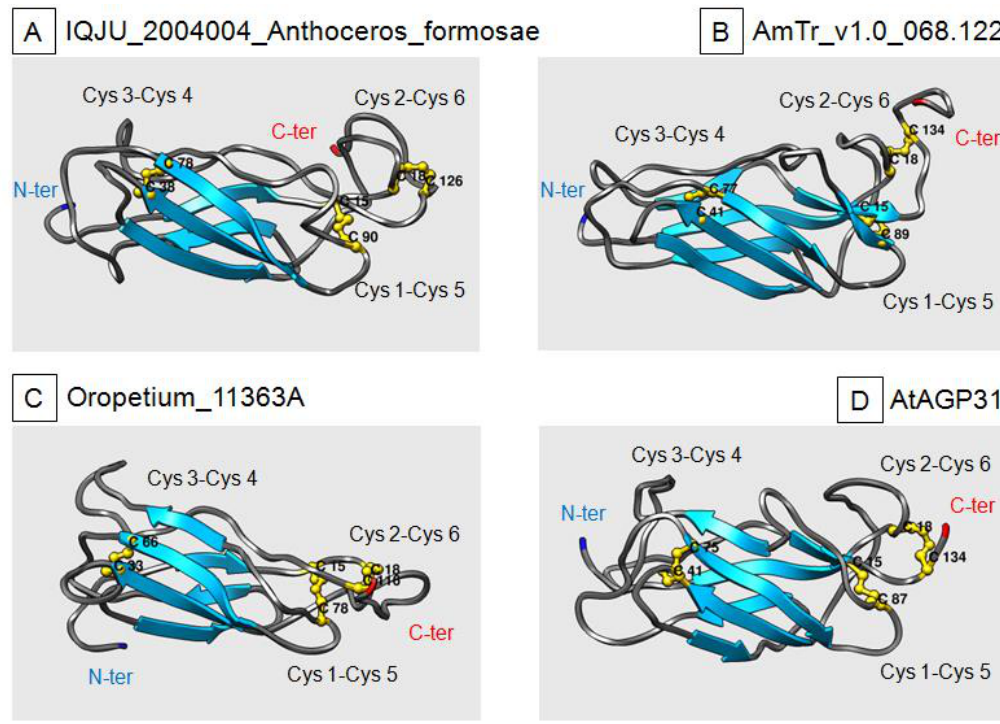
Figure 5. 3D-modeling of four PAC domains. ( A ) A representative PAC domain of Bryophytes: IQJU_2004004_Anthoceros_formosae. ( B ) A PAC domain of A. trichopoda : AmTr_v1.0_068.122. ( C ) A representative PAC domain of the O. thomaeum monocot: Oropetium_11363A. ( D ) A representative PAC domain of the A. thaliana dicot: At1g28290. The N-terminus (N-ter) and the C-terminus (C-ter) of the proteins are indicated in blue and red, respectively. Blue ribbons represent β -sheets. The three disulfide bridges are drawn in yellow, and the names of the Cys residues involved are indicated.